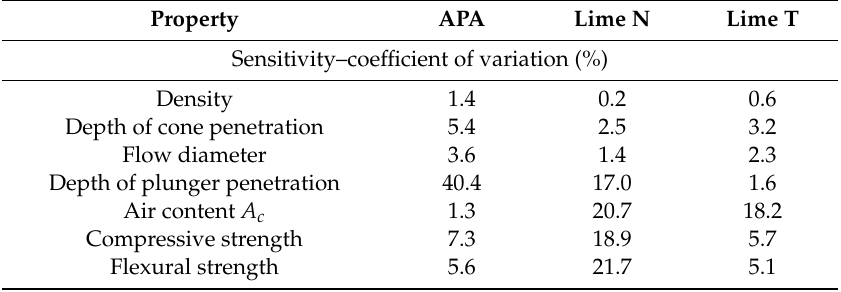
Table 11. The sensitivity of plaster properties to mistakes in dosing lime or APA.